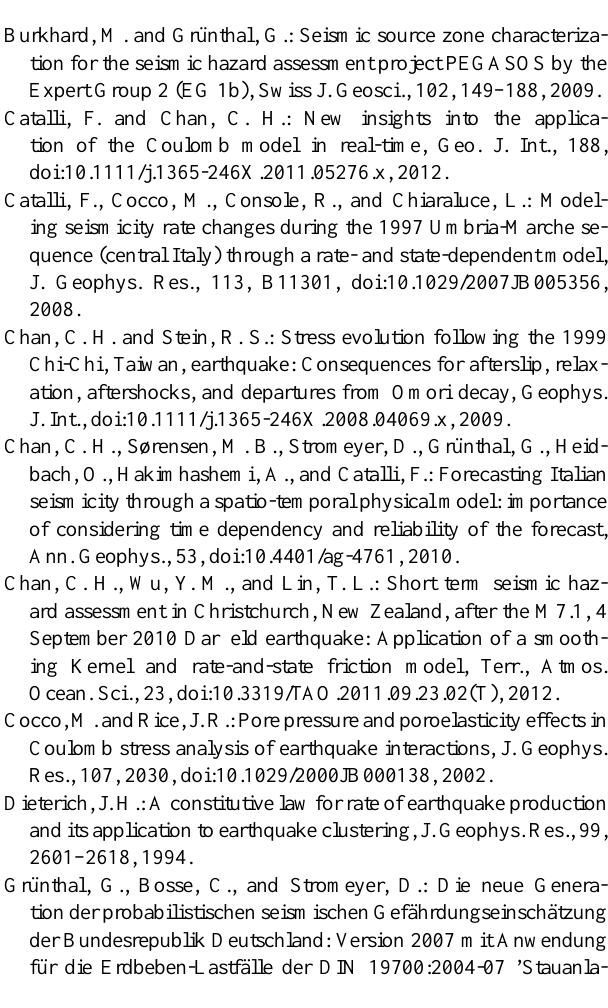
Fig. 9. The Molchan diagram for the test of forecasting ability using different target depths and maximum 1 CFS among the seismogenic